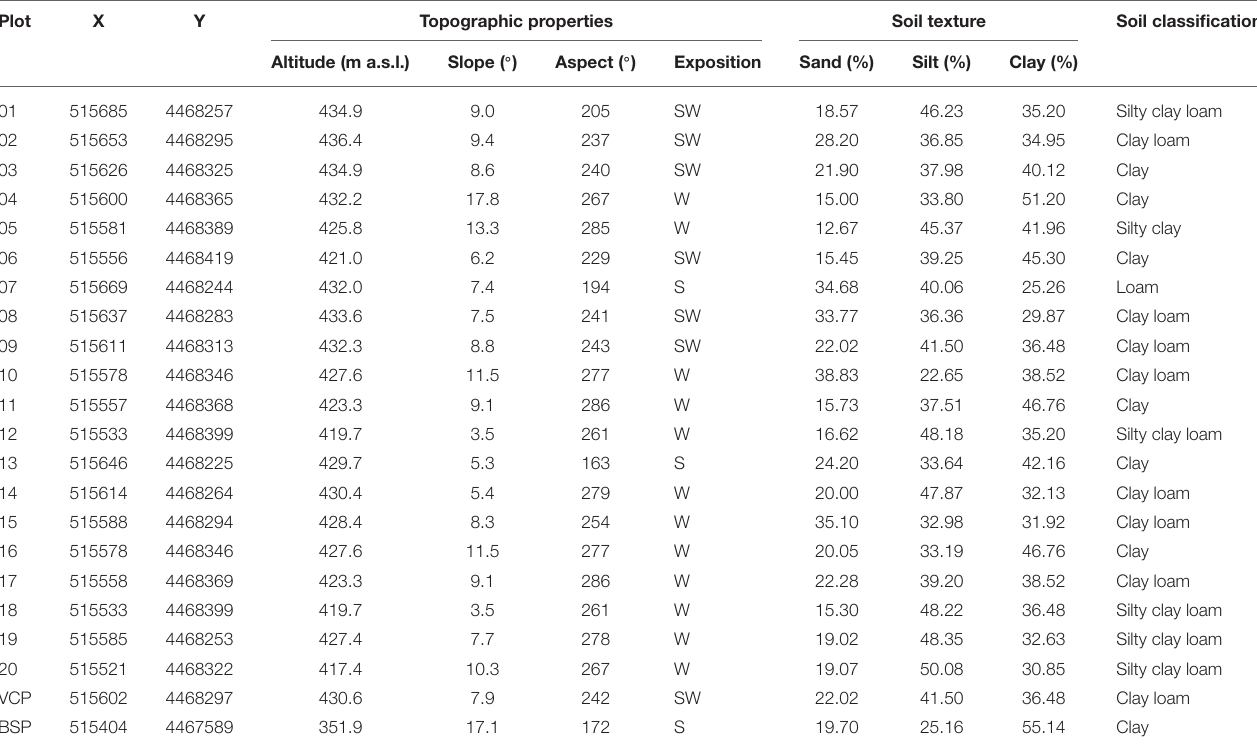
TABLE 1 | Geographical positions (WGS 84/UTM zone 33N), topographic characteristics as derived from a DEM with a cell size of 5m, and topsoil (0–5cm) properties of the 20 SoilNet units (01–20) and the stationary sensor locations VCP and BSP. Plot X Y Topographic properties Soil texture Soil classification Altitude (m a.s.l.) Aspect ( ◦ )